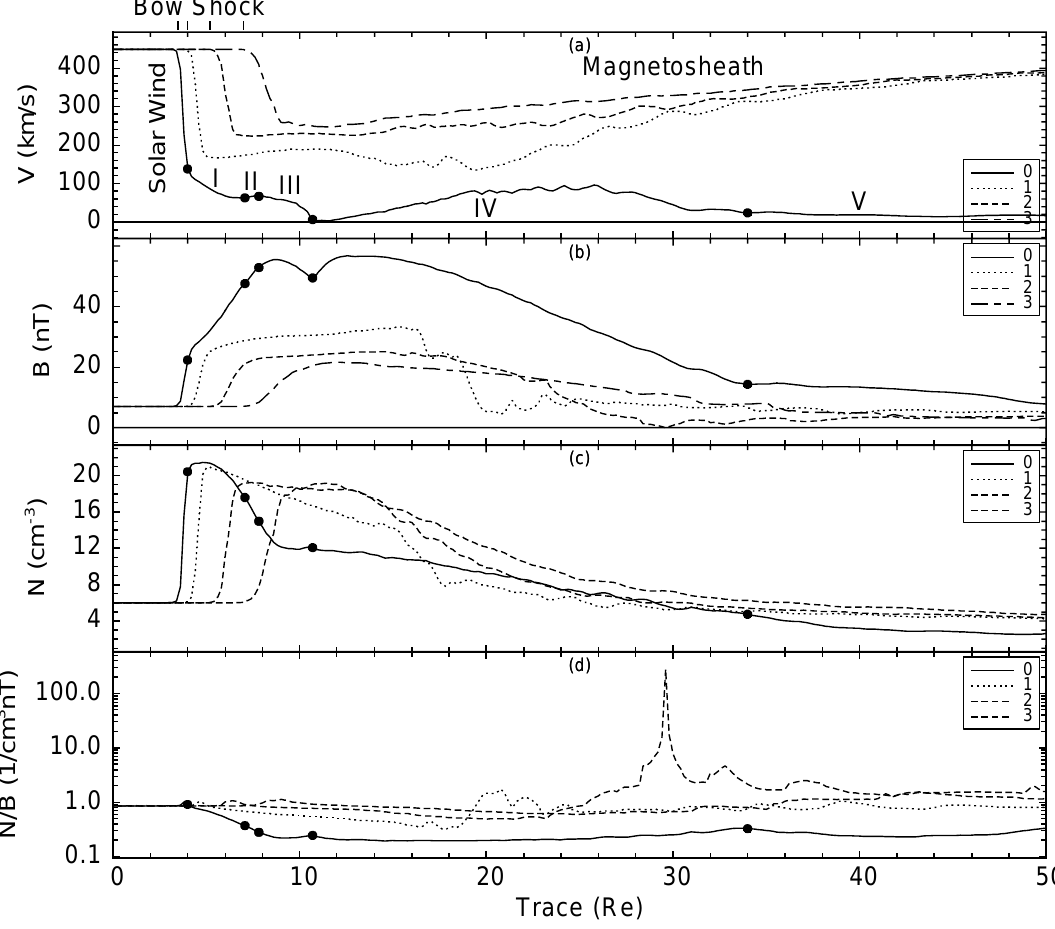
Fig. 11. Values along the streamlines in the right panel of Fig. 8. The other settings are the same as those in Fig. 9. The PDL feature, decreased plasma density and enhanced magnetic field is only seen clearly on streamline 0, which is closest to the magnetopause, from ∼ 6 R E to ∼ 9 R E